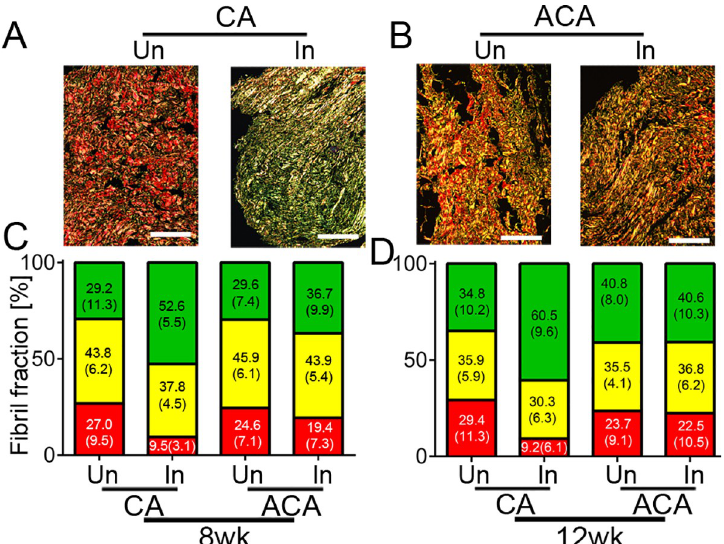
Fig 4. Histological quantification of various populations of picrosirius-stained collagen fibrils formed within injured posterior capsules (PCs). A, Samples of the PCs from uninjured (Un) and injured (In) knee joints of rabbits treated with control antibody (CA). B, Samples of the PCs from uninjured (Un) and injured (In) knee joints of the rabbits treated with the ACA. C&D, Corresponding graphs depict the percentages, with standard deviations in parentheses, of the green birefringence (GB), yellow birefringence (YB), and red birefringence (RB) subpopulations of collagen fibrils observed with the use of a polarized light microscope in the 8wk and 12wk groups. Bars = 100 μ m.